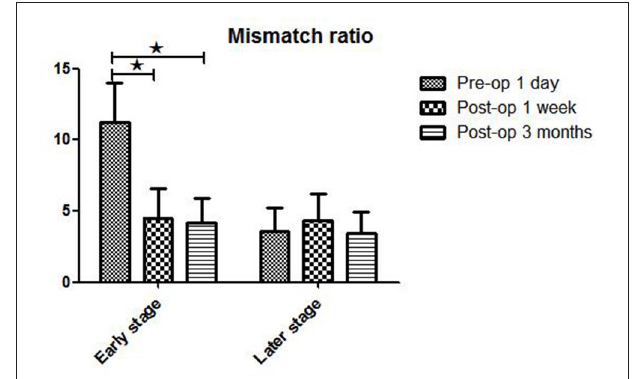
FIGURE 4 | WB-CTP showing hemodynamic characteristics in mismatch ratio in ischemic MMD patients of different Suzuki stages (II–V stage) at different time points. Early stage: in Suzuki stage II and III Later stage:in Suzuki stage IV and V. *MR, mismatch ratio (volume of DT > 3 divide volume of rCBF < 30%), ⋆ P < 0.05.